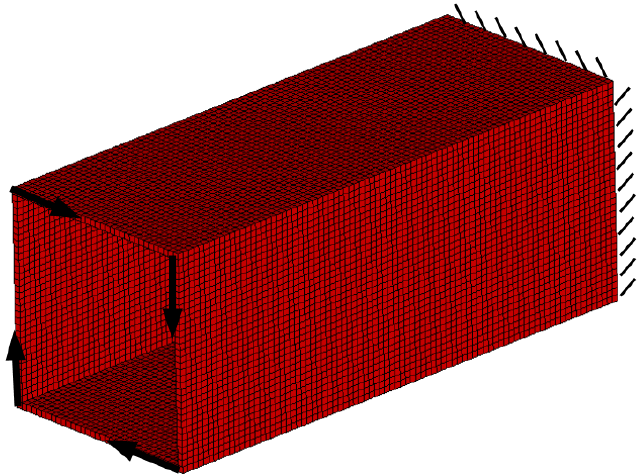
Figure 27. The box tube: dimensions in mm.